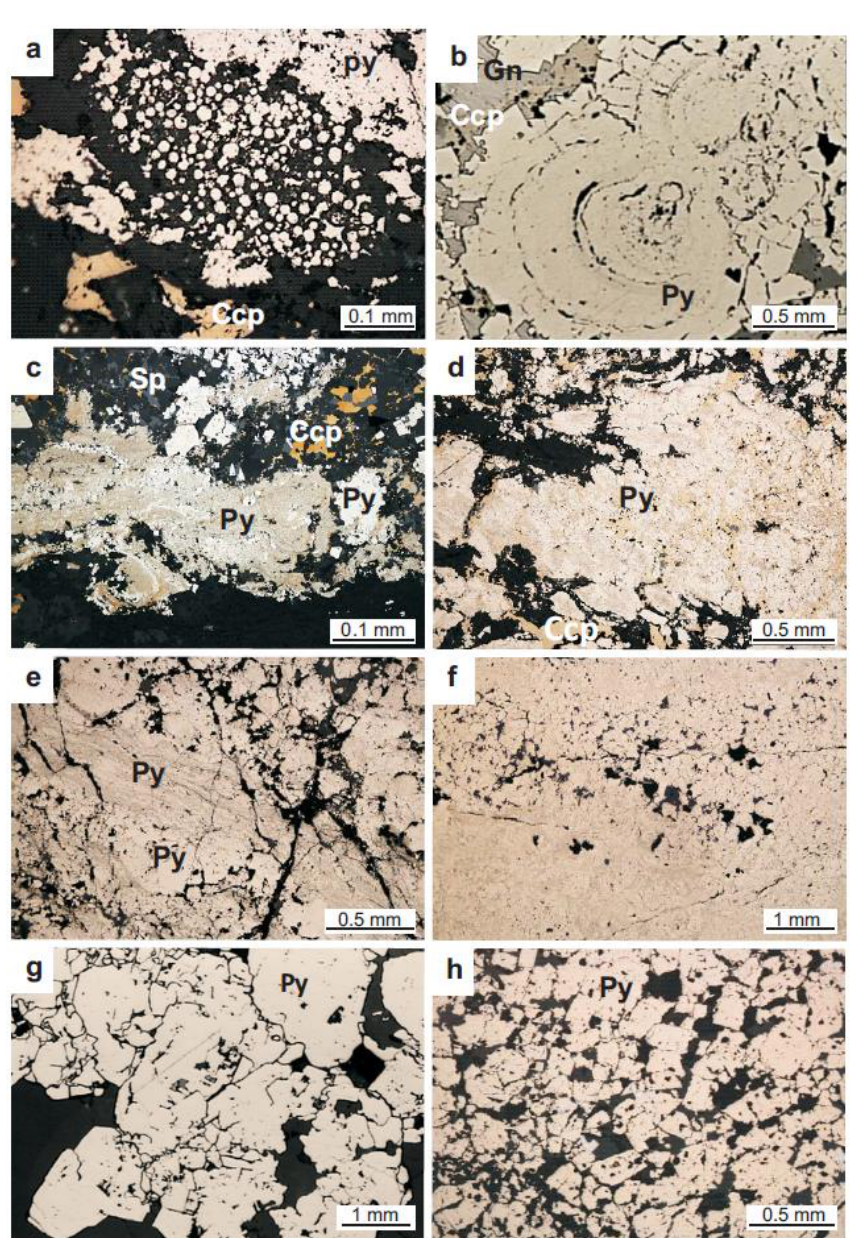
Figure 5. Optical microscope images of pyrite mineralizations from several massive sulfide deposits of the IPB. ( a ) framboidal pyrite (Py) aggregates partially recrystallized and late interstitial chalcopyrite (Ccp); ( b ) colloform pyrite nucleating over early framboids and late interstitial galena (Gn) and chalcopyrite; ( c ) very fine grained pyrite aggregates partially recrystallized and replaced by chalcopyrite and sphalerite (Sp); ( d ) porous aggregates of pyrite microcrystals partially recrystallized; ( e ) irregular banding of coarse grained pyrite and microcrystal aggregates; ( f ) massive pyrite generated by recrystallization of fine grained facies. The uneven recrystallization led to open spaces susceptible to be filled by later phases; ( g ) coarse subidiomorphic pyrite aggregates; and ( h ) oquerous pyrite showing open spaces formed by other sulfides corrosion and dissolution during distillation processes. Magdalena deposit ( a , c , d , h ), Aznalcóllar deposit ( b , g ) and Massa Valverde deposit ( f ).